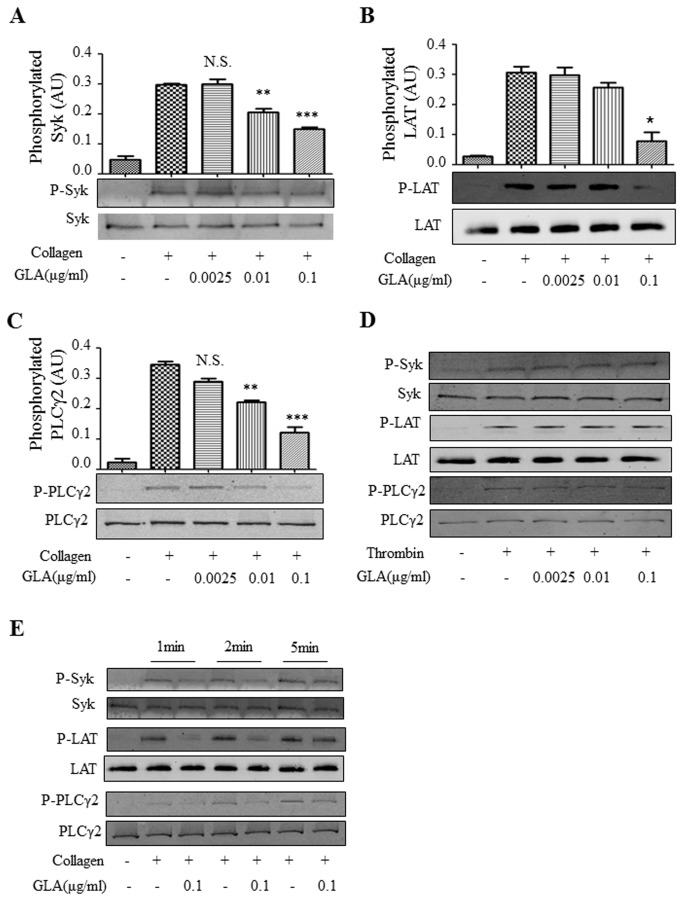
Influences of GLA on platelet intracellular signaling.Gel-filtered platelets (2.5×108/ml) were pre-incubated with vehicle (DMSO) or GLA (0.0025, 0.01, 0.1μg/ml), and stimulated with collagen (2μg/ml) with stirring at 900 rpm in an aggregometer at 37°C for 60 seconds. Platelets were lysed, and immunoblotted using the corresponding antibodies recognizing total and phosphorylated Syk (A), total and phosphorylated LAT (B), and total and phosphorylated PLCγ2 (C). After incubation with the goat anti-rabbit IRDye 800CW or goat anti-mouse IRDye 800CW (LI-COR Biosciences, Lincoln, NE, USA), densitometric band scanning was performed using an Odyssey Infrared Imaging System (LI-COR Biosciences) (mean ± standard error, n=3). **P <0.01. ***P <0.001. N.S., not significant compared to vehicle control. The statistical significance was determined by one-way ANOVA analysis of variance with the Bonferroni post test. Same methods were used to measure the time course of GLA inhibition (D) and thrombin control (E) for the phosphorylation of the three signaling molecules in the GPVI pathway. The gels are the representatives of at least three individual experiments.